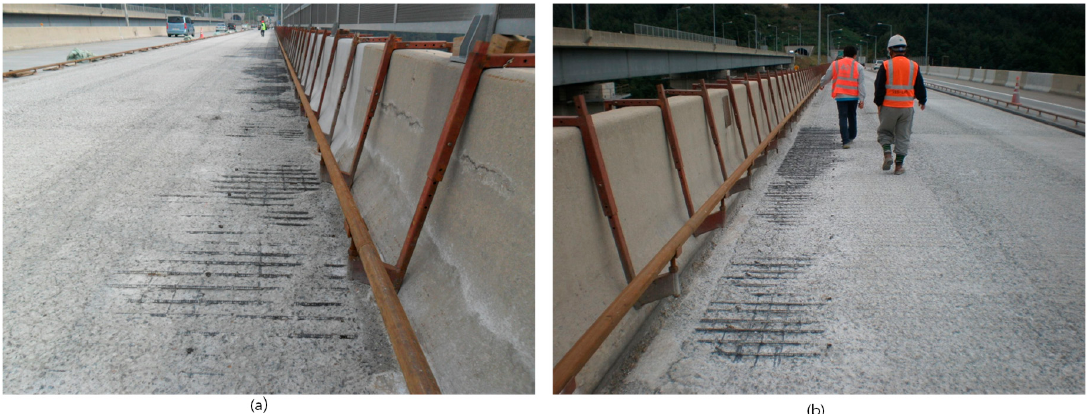
Figure 13. Actual concrete condition after removing the asphalt overlay and deteriorated concrete using a high-pressure water-jet machine in the target bridge (“J” bridge) after the GPR survey: ( a ) area 1 and ( b ) area 2 (see Figure